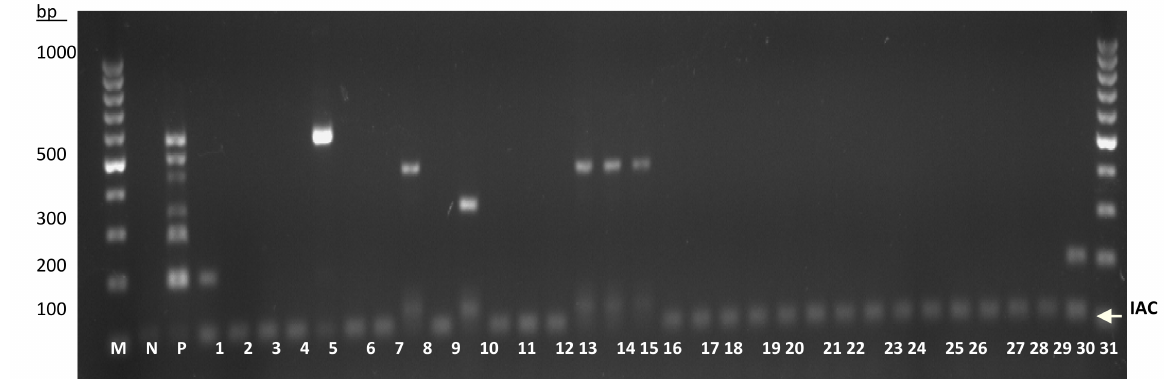
Figure 4. A randomized, blind test for the accuracy performance of the single-tube heptaplex PCR on clinical isolates ( n = 31). The presence of amplicon bands on the agarose gel corresponds to the respective target organisms, whereby the accuracy performance of this assay was compared to the blinded test. Lane M: 100 bp DNA ladder, Lane N: IAC, Lane P: